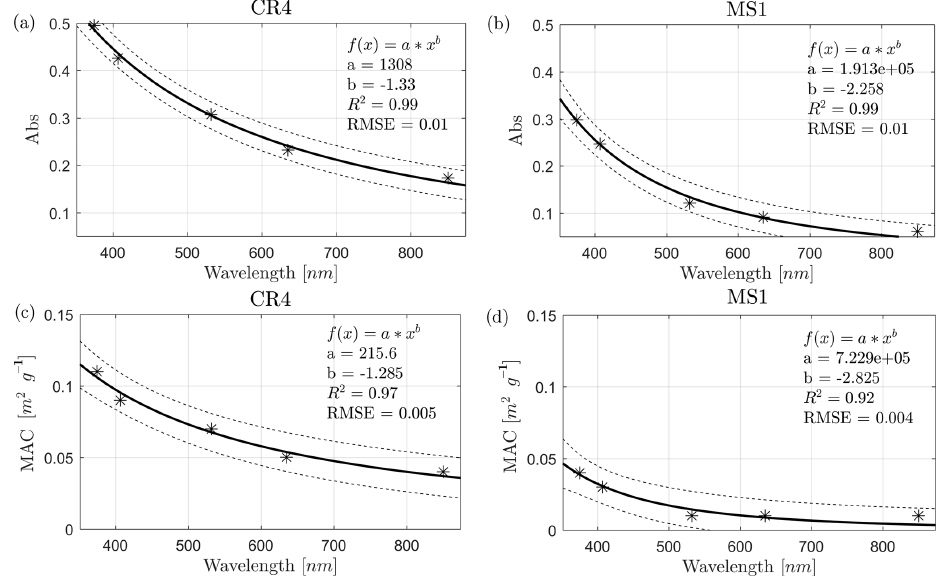
Figure 10. (a–b) Absorbance (Abs) of a cryoconite (CR4) and a moraine sediment (MS1) sample. (c–d) mass absorption cross section (MAC) of the same samples. Solid lines represent power law fits, and dashed lines are the prediction boundaries at